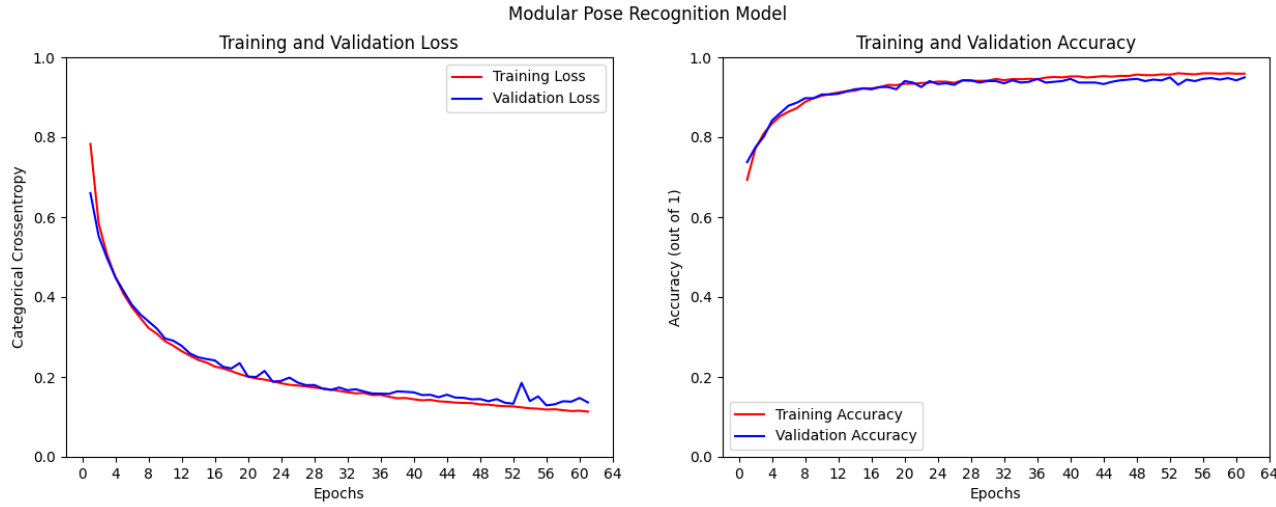
Figure 7. Graphs of the the modular classifier’s training process. On the left , the categorical crossentropy values for the training and validation sets are plotted by epoch. On the right , training and validation accuracy are plotted by epoch. This classifier is the component in the fourth box (“classification”) in Figure